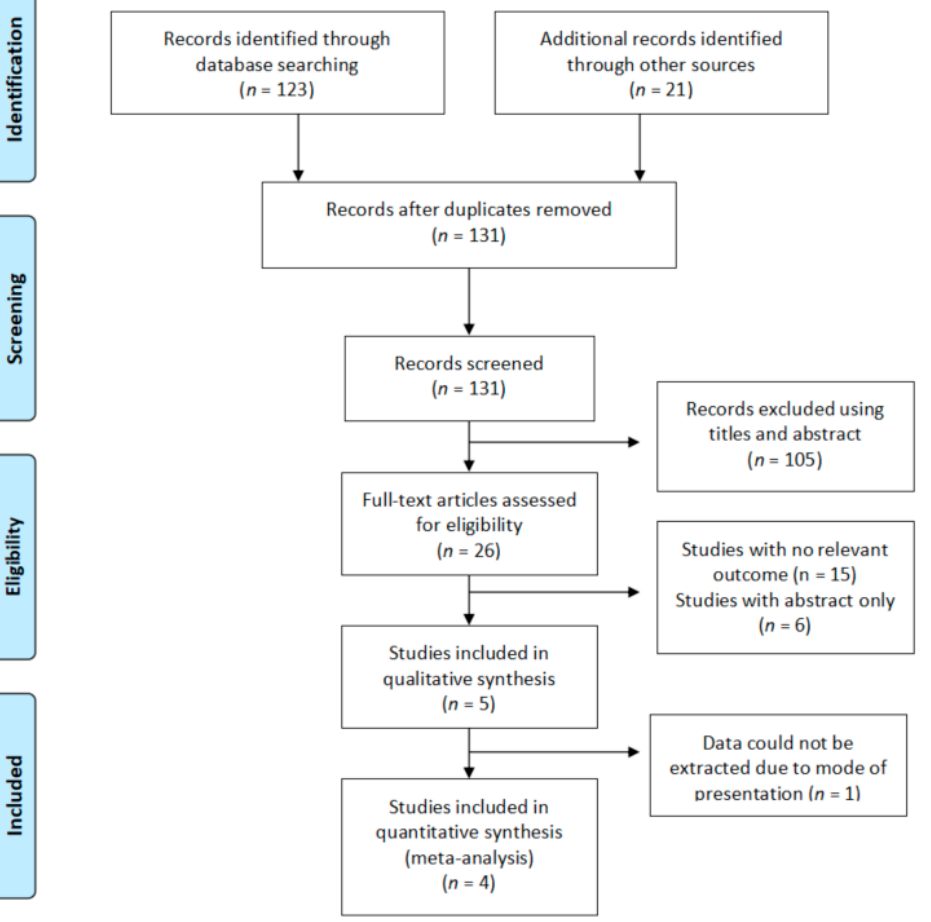
Figure 2. Flow diagram of the search strategy for Centella asiatica .